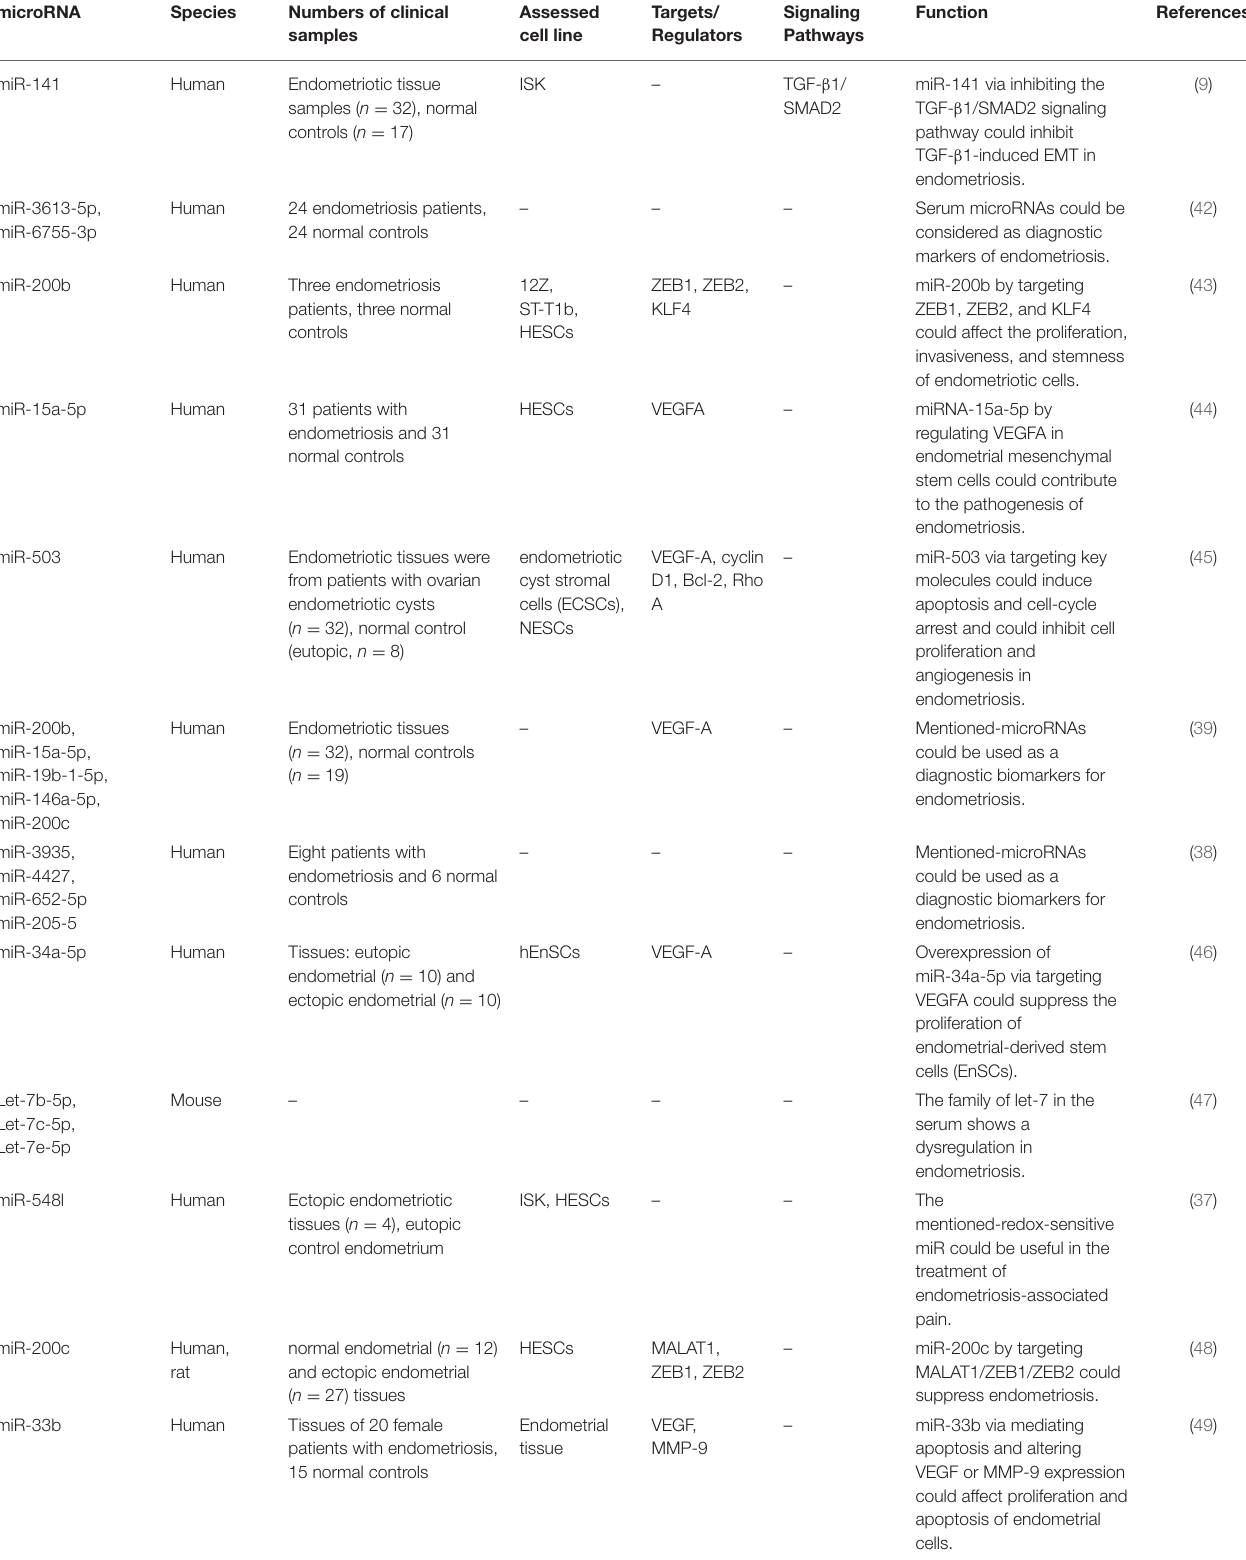
TABLE 2 | List of down-regulated miRNAs in